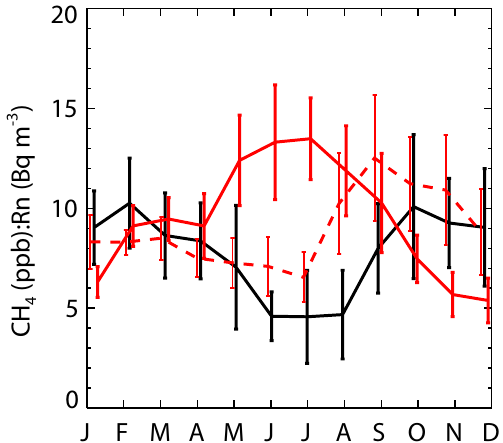
Figure 8. Mean seasonal cycle of residual methane to radon ratios for the CTL methane scenario (red, solid) and the CTL methane fluxes shifted forward in time by three months (red, dashed) com- pared to the observations (black). Both simulations used the CCAM